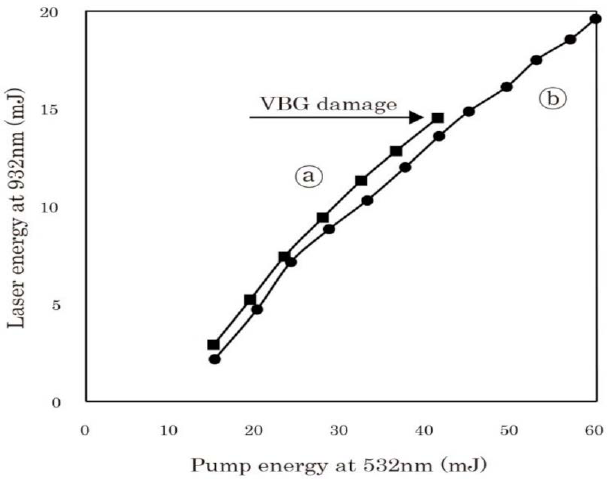
Figure 1. Energy characteristics of Ti:Sapphire laser with VBG ( a ) and STG ( b ). Reprinted with permission from ref. [8]. Copyright 2015 © The Optical